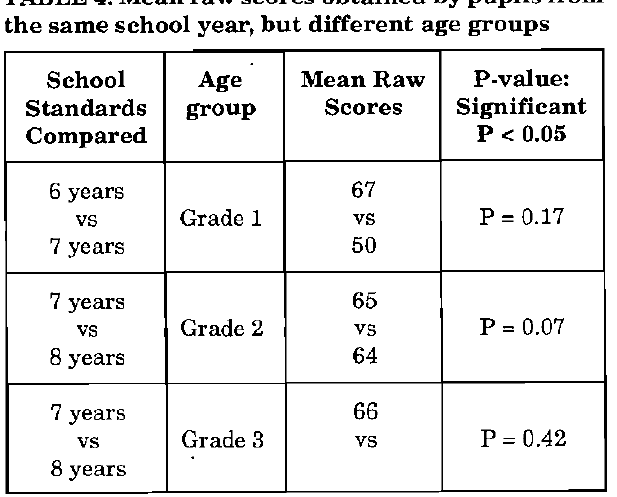
TABLE 4: Mean raw scores obtained by pupils from